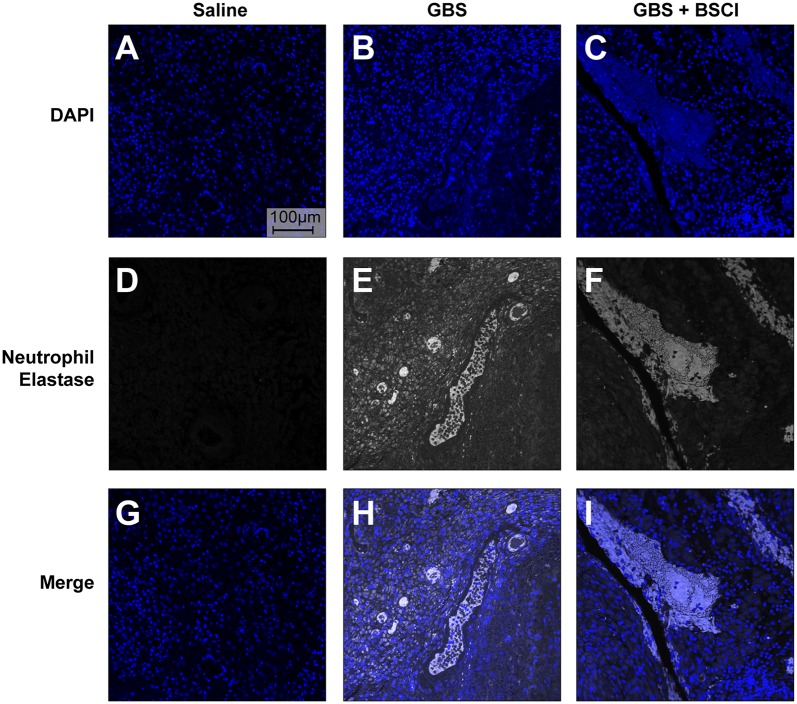
BSCI does not impact neutrophil extracellular traps formed in the chorioamnion during GBS infection in our NHP model. Immunofluorescence staining for neutrophil elastase was performed on chorioamniotic membranes in the saline (A,D,G), GBS (B,E,H), and the BSCI+GBS group (C,F,I). Data shown is representative of five animals from each group. Neutrophil elastase staining is shown in gray and DAPI is shown in blue.